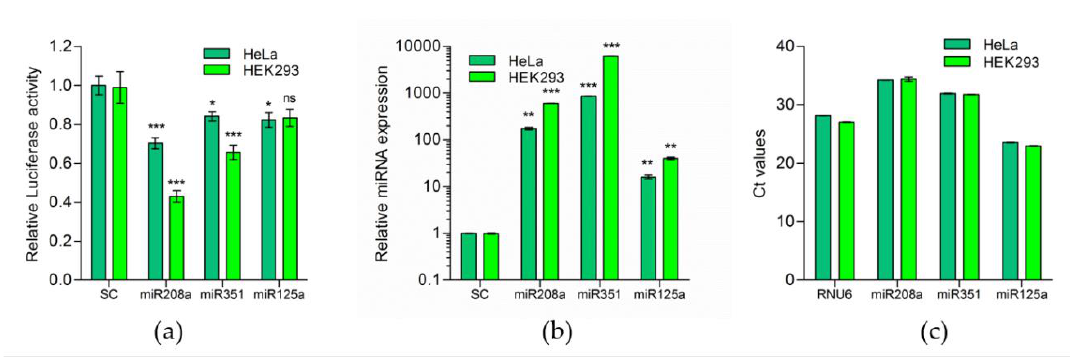
Figure 2. Predicted murine miRNAs indeed target 3′UTR of murine F8 -mRNA. ( a ) Relative luciferase activity in HeLa and HEK293 cells transfected with luciferase and miRNA expression vectors for miR-208a, miR-351 and miR-125a (HeLa: SC = 1.00 ± 0.049, N = 9; miR-208a = 0.7027 ± 0.02843, N = 9; miR-351 = 0.8413 ± 0.02369, N = 9; miR-125a = 0.8222 ± 0.03816, N = 6; HEK293: SC = 0.9881 ± 0.08065 N = 8. miR-208a = 0.4297 ± 0.02946, N = 11; miR-351 = 0.6558 ± 0.03693, N = 11; miR-125a = 0.8339 ± 0.04463, N = 5.). ( b ) Quantitative polymerase chain reaction (qPCR) analysis to determine the overexpression level of miRNAs 72 h after transfection (Mean ± SEM for HeLa: SC = 1.000 ± 0.01171, N = 3; miR-208a = 174.5 ± 11.15 N = 3; miR-351 = 864.1 ± 9.904 N = 3, miR-125a = 15.98 ± 1.498, N = 3; HEK293: SC = 1.000 ± 0.02263, N = 3; miR-208a = 599.8 ± 1.916, N = 3; miR-351 = 6183 ± 10.04, N = 3; miR-208a = 40.01 ± 2.491 N = 3) and ( c ) Expression (Ct values) of endogenous miRNAs: miR-208a, miR-351 and miR-125 in HeLa and HEK293, relative to RNU6 (HeLa: RNU6 = 28.14 ± 0.015, N = 3; miR-208a = 34.24 ± 0.017, N = 3; miR-351 = 31.92 ± 0.056, N = 3; miR-125a = 23.55 ± 0.052, N = 3; HEK293: RNU6 = 27.06 ± 0.058 N = 3. miR-208a = 34.40 ± 0.37, N = 3; miR-351 = 31.76 ± 0.033, N = 3; miR-125a = 22.95 ± 0.060, N = 3). * p < 0.05 ** p < 0.01, *** p < 0.001; SC = Scrambled miRNA expressing plasmid control.